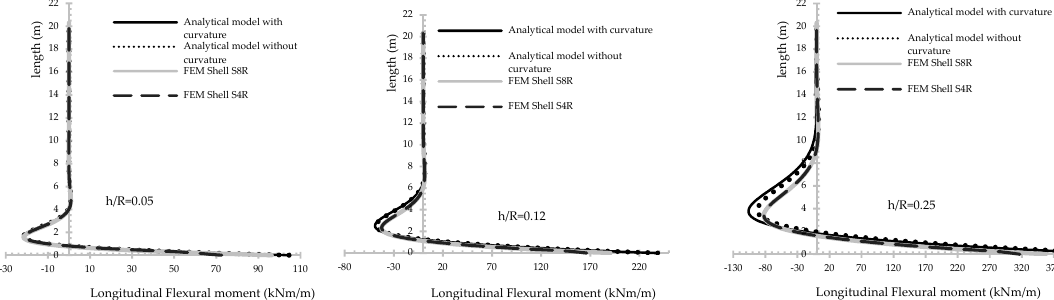
Figure 13. Circumferential flexural moment for thin, medium and thick shells, considering different models. 7. Conclusions The formulation and analytic solution presented in this paper displays the generality of combining the Mindlin–Reissner theory, the shear correction factor properly for cylin- drical shell and the general coupled constitutive model (isotropic and orthotropic) with- out disregarding the shell curvature from the constitutive. The proposed mathematical model presents three independent degrees of freedom ((cid:1847) (cid:3041) , (cid:1847) (cid:3053) , (cid:2032) (cid:3053) ) and it is formulated in terms of the resultant internal forces per unit of arc longitude. This has the advantage of allowing the analysis of cylindrical shell by analytical formulation with thin, medium and thick thickness under a general distribution of axial- symmetric pressures with the very best numerical reliability in the entire shell domain. Potentially engineering applications include tunnel ventilation shafts, tubular piles under earth pressures, tanks under hydrostatic pressures, reinforced concrete silos under granular solid pressures, gas-filled cisterns, simple alteration effect analysis in thin and medium shells and chimneys. A practical example has been illustrated in a tunnel venti- lation shaft analysis for different slenderness ratio (cid:4672) (cid:3035) (cid:3019) (cid:4673) , resulting in the following signifi- cant conclusions: 1. When the isotropic shell is thin, (cid:4672) (cid:3035) (cid:3019) ≤ 0.05(cid:4673) its predominant resistant mechanism is the circumferential membrane force with an inversion of bending moments in the both main directions. From an increase in the slenderness ratio, the flexural contri- bution in the two main directions dominated the internal equilibrium of the shell and the inserting of the constitutive curvature acquires the biggest importance in the structural response of the shell. For analysis and tunnel ventilation shafts design with slenderness ratio of (cid:3035) (cid:3019) ≥ 0.12 it is recommendable to insert the constitutive curva- ture;